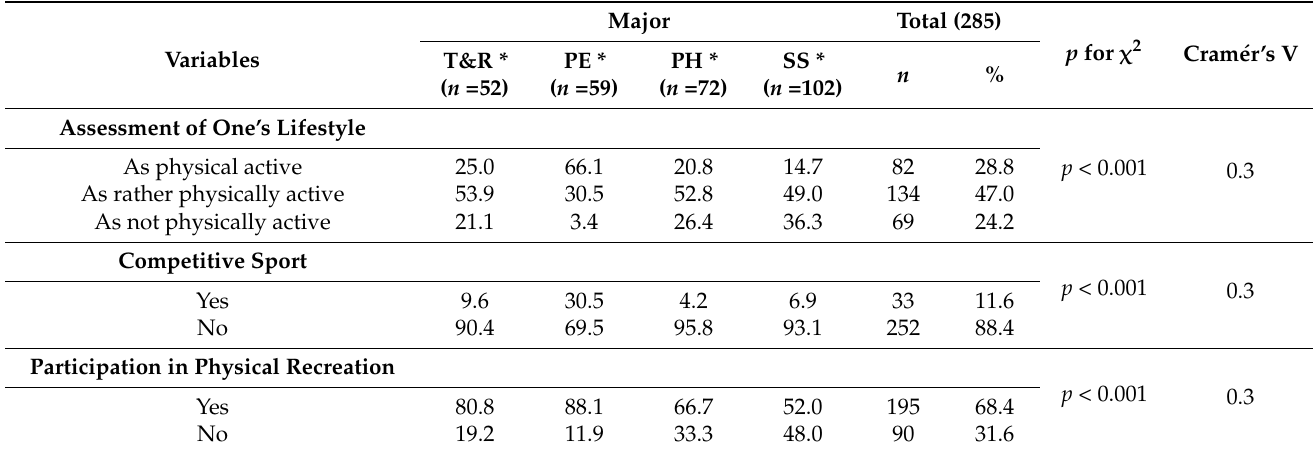
Table 2. Physically active lifestyle as assessed by the female respondents, participation in physical recreation, and doing sports by major (independence χ 2 test and Cram é r (cid:48) s